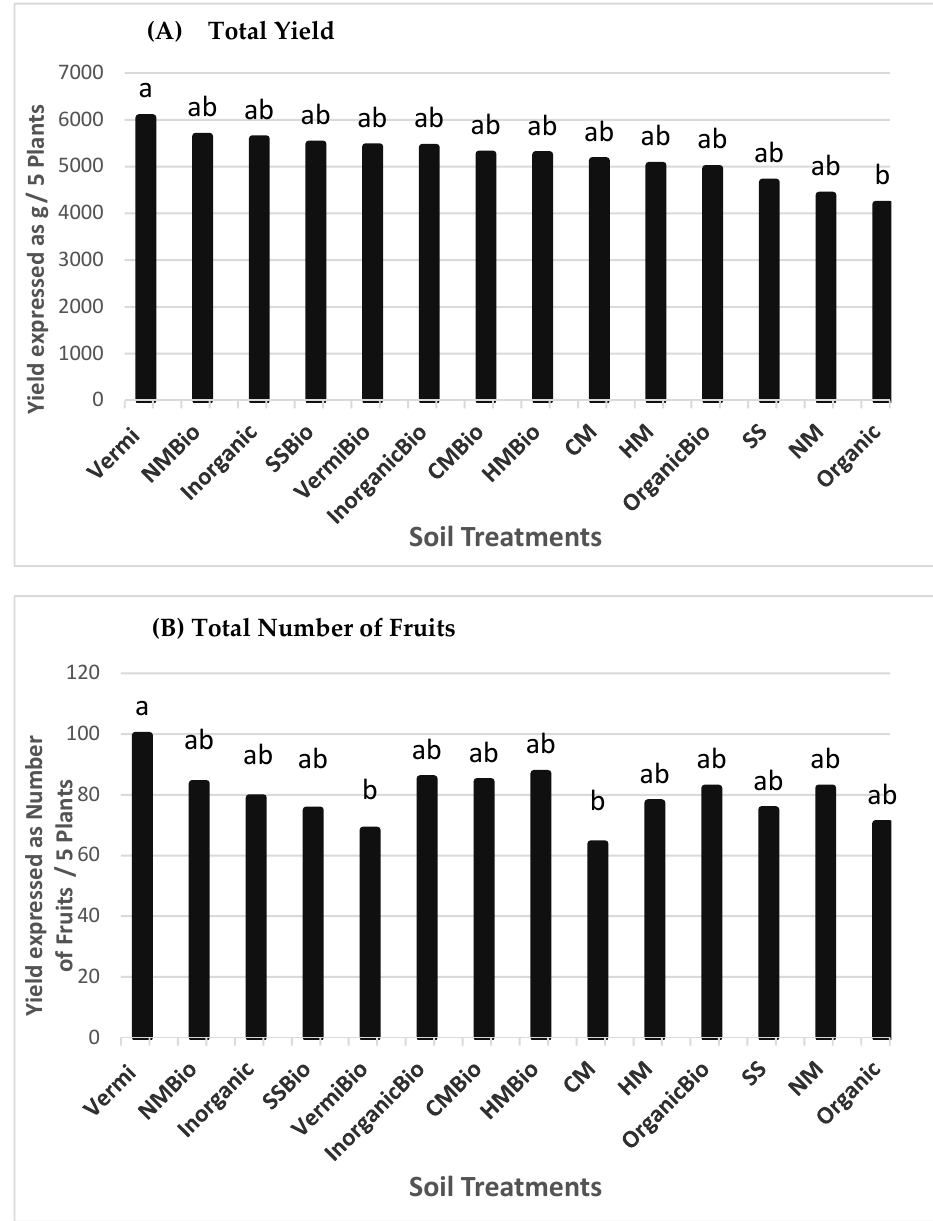
Figure 2. Yield of tomato ( A ) and fruits numbers ( B ) of plants grown in soils mixed with amendments: Vermicompost (Vermi), no-mulch soil mixed with biochar (NMBio), inorganic fertilizer (Inorganic), sewage sludge mixed with biochar (SSBio), vermicompost mixed with biochar (VermiBio), inorganic fertilizer mixed with biochar (InorganicBio), chicken manure mixed with biochar (CMBio), horse manure mixed with biochar (HMBio), chicken manure (CM), horse manure (HM), organic fertilizer mixed with biochar (OrganicBio), sewage sludge (SS), no-mulch bare soil (NM), and organic fertilizer (Organic). Values accompanied by the same letter(s) are not significantly different ( p > 0.05).